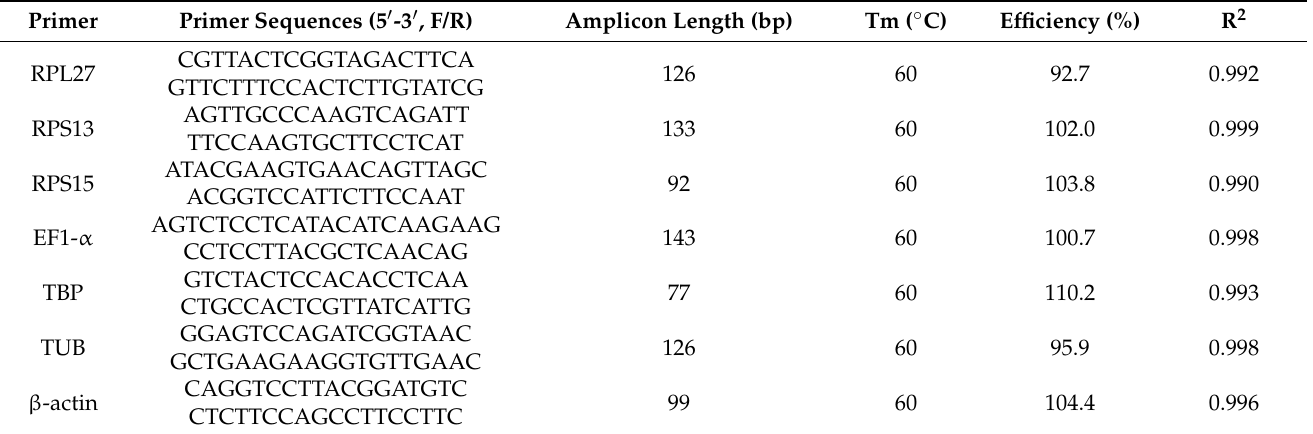
Table 2. Reference genes and specific primers used for RT-qPCR analysis in T. absoluta . Primer Primer Sequences (5 (cid:48) -3 (cid:48) ,